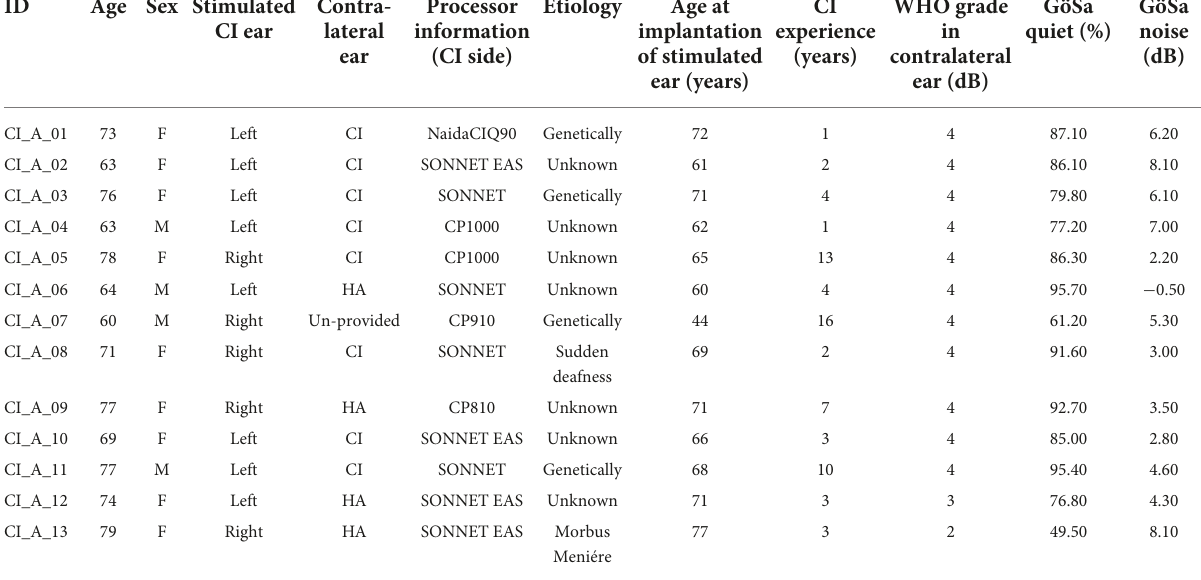
TABLE 2 Demographic variables of the elderly participants with